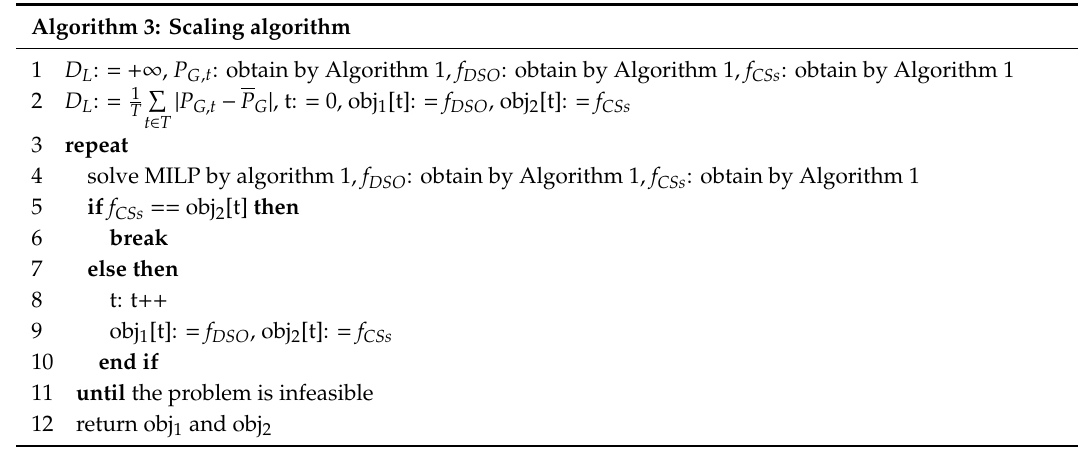
9 of 14 Algorithm 3: Scaling algorithm